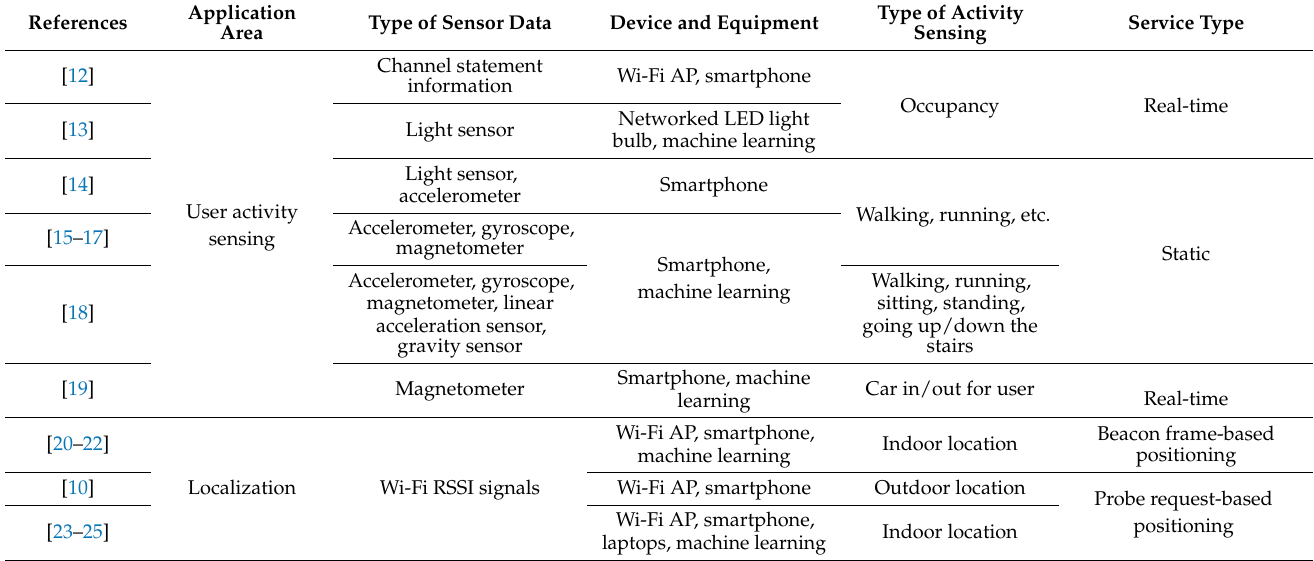
Table 1. Comparison between related